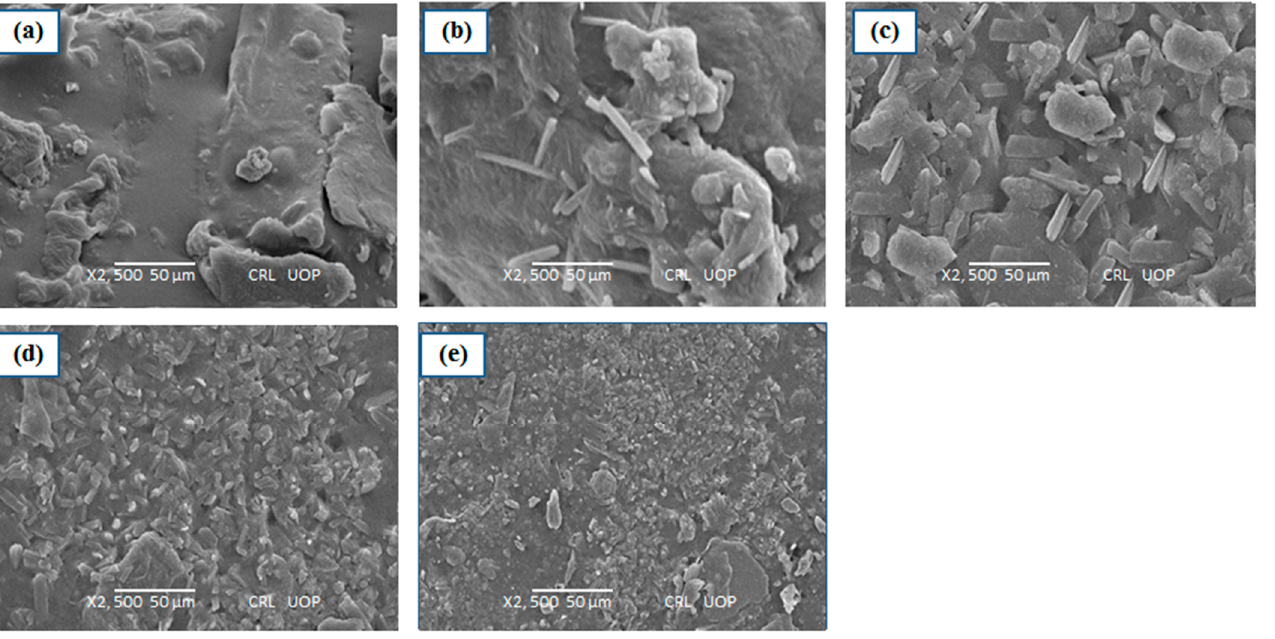
Figure 4. Surface Morphlogy of ( a ) F1, ( b ) F2, ( c ) F3, ( d ) F4, ( e ) F5.